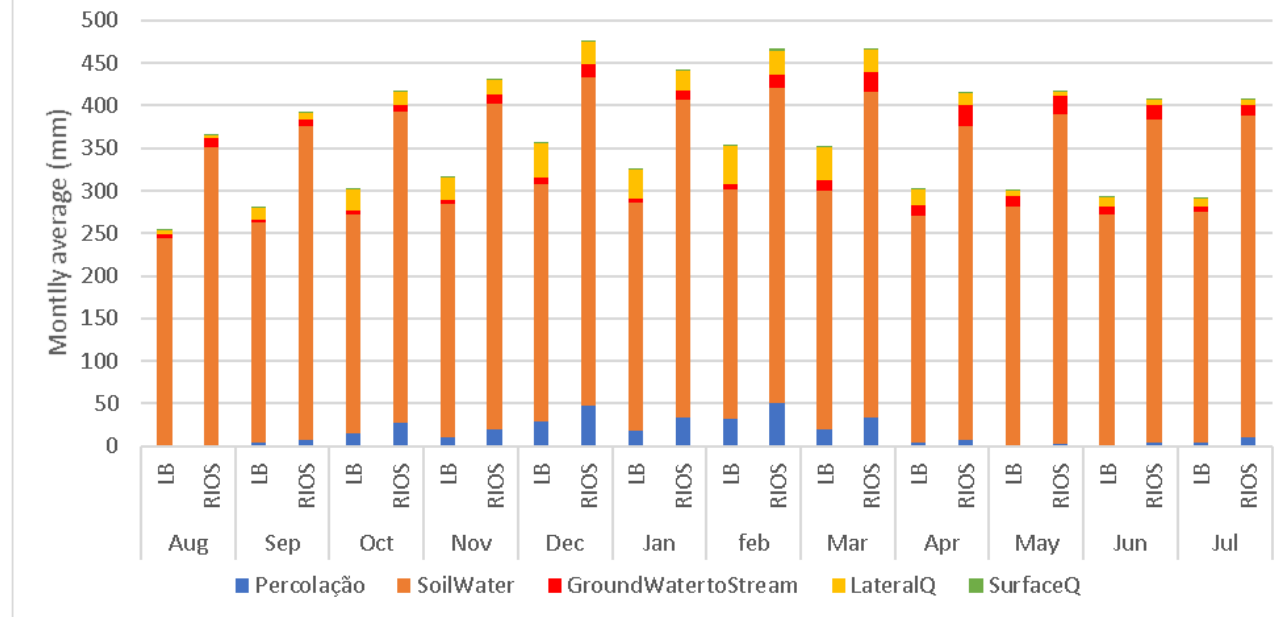
Figure 11. SWAT monthly average water balance outputs for the 2013 – 2015 drought period (comparing customized RIOS scenario against baseline (LB)).